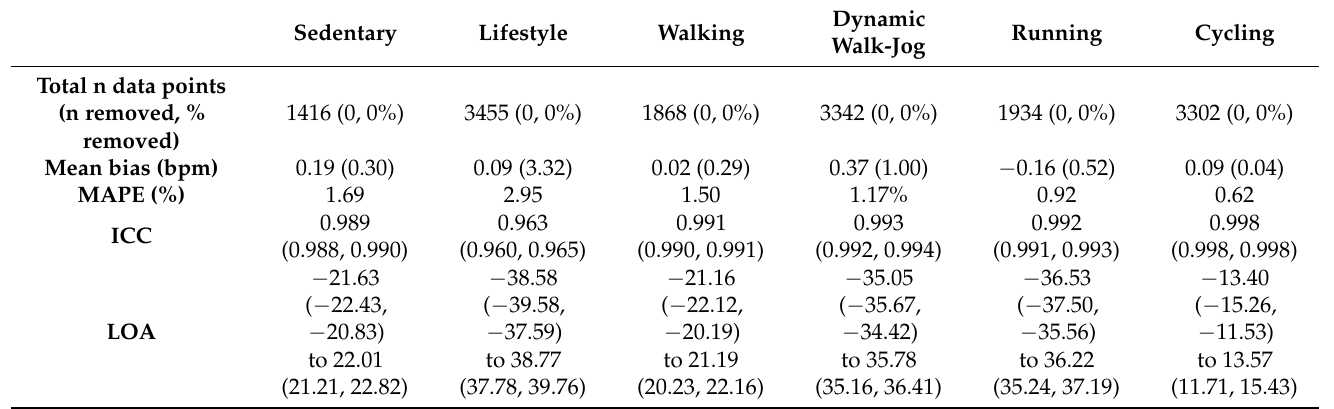
Figure 8. Bland – Altman plots of heart rate (bpm) during cycling activity for the ( A ) Apple Watch seriew 4, ( B ) Garmin Forerunner 735XT, ( C ) Jabra Elite earbuds, and ( D ) Scosche Rhythm 24 devices compared to the Polar H7. Dashed lines represent 95% limits of agreement. Table 1. Results of all tests for the Apple Watch Series 4.